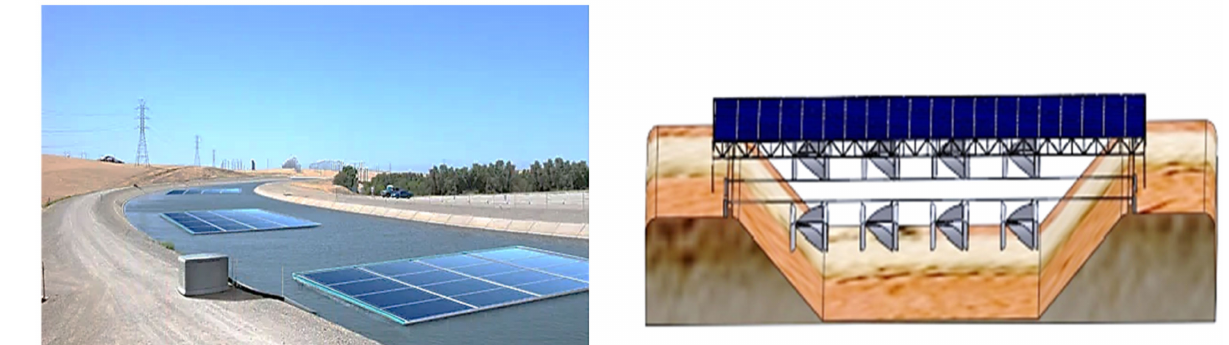
Figure 7. Floating + micro hydrokinetic concept. (Source: Bourne Energy, USA)